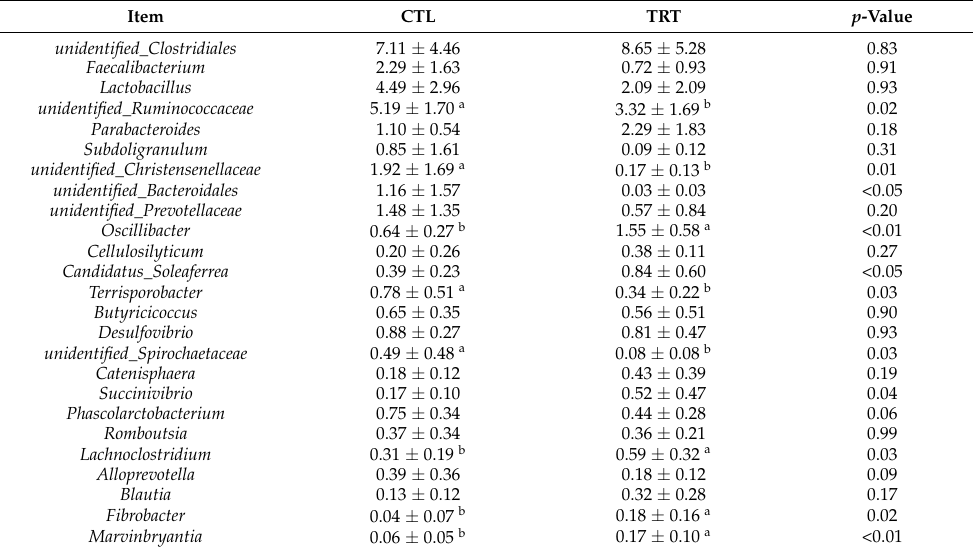
Table 4. The effect of dietary silymarin supplementation on the relative abundances at the genus level (%, the relative abundance > 0.15%) in lactation sow feces.